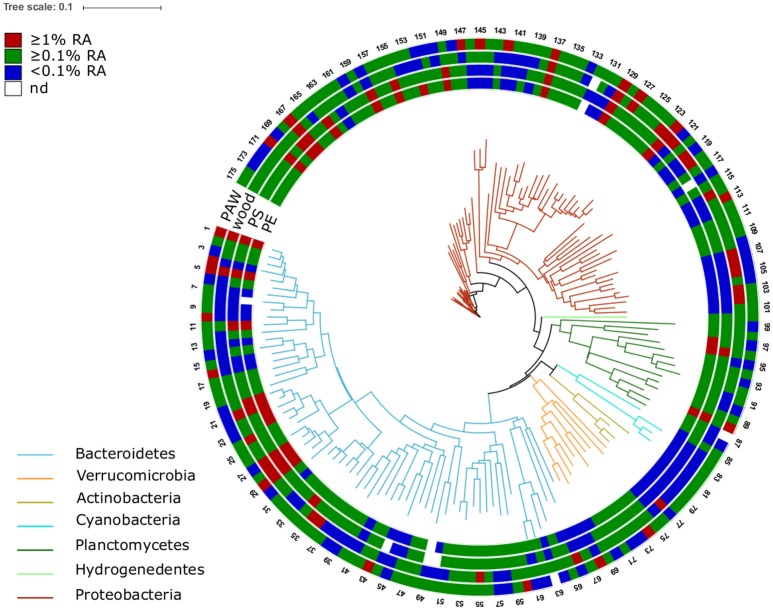
Phylogenetic tree of the 175 OTUs (16S rRNA data based) displaying an average relative abundance of ≥0.1% across the whole dataset. The colors of the branches refer to different bacterial phyla. The outer rings represent different sample sources: particle-attached water community (PAW), wood-, PE-, and PS-associated assemblages. The colors in the rings indicate the mean relative abundance of the OTUs in the individual sample sources across all stations. Scale bar represents 10 nucleotide substitutions per 100 nucleotides. Families with ≥ 3 OTUs are listed below. For more taxonomic details of OTUs see Additional file 4. 1–36: Flavobacteriaceae; 41–45: Cryomorphaceae; 52–58, 60: Saprospiraceae; 68, 69, 71, 73–75: Verrucomicrobiaceae; 78–80: Microbacteriaceae; 82–84: Cyanobacteria Family I; 86–96: Planctomycetaceae; 106, 107, 118, 119: Cellvibrionaceae; 122–130: Comamonadaceae; 131, 134–136: Rhodocyclaceae; 144–146: Campylobacteraceae; 150, 152, 153: Erythrobacteraceae; 155–158: Hyphomonadaceae; 159–175: Rhodobacteraceae.